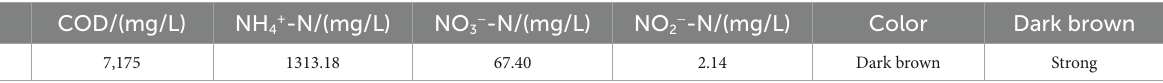
TABLE 1 Characteristics of landfill leachate.